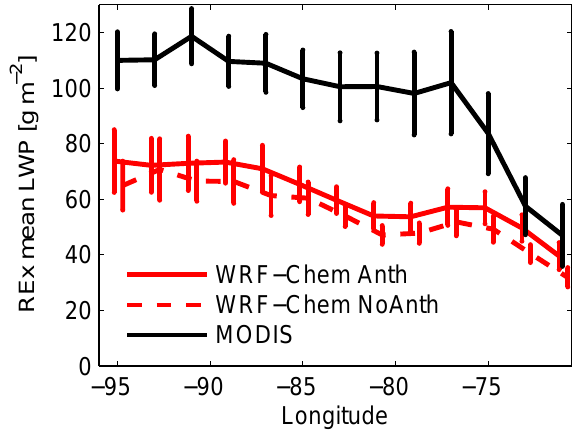
Fig. 4. VOCALS-REx mean N d 19–21 ◦ S from MODIS retrievals (black), VOCALS flight data (blue) and WRF-Chem model output (red, at 15:00UTC to compare with MODIS) for Anth (solid) and NoAnth (dashed) simulations in 2 degree longitude bins. Error bars show the 95% confidence interval of the standard error of the mean.